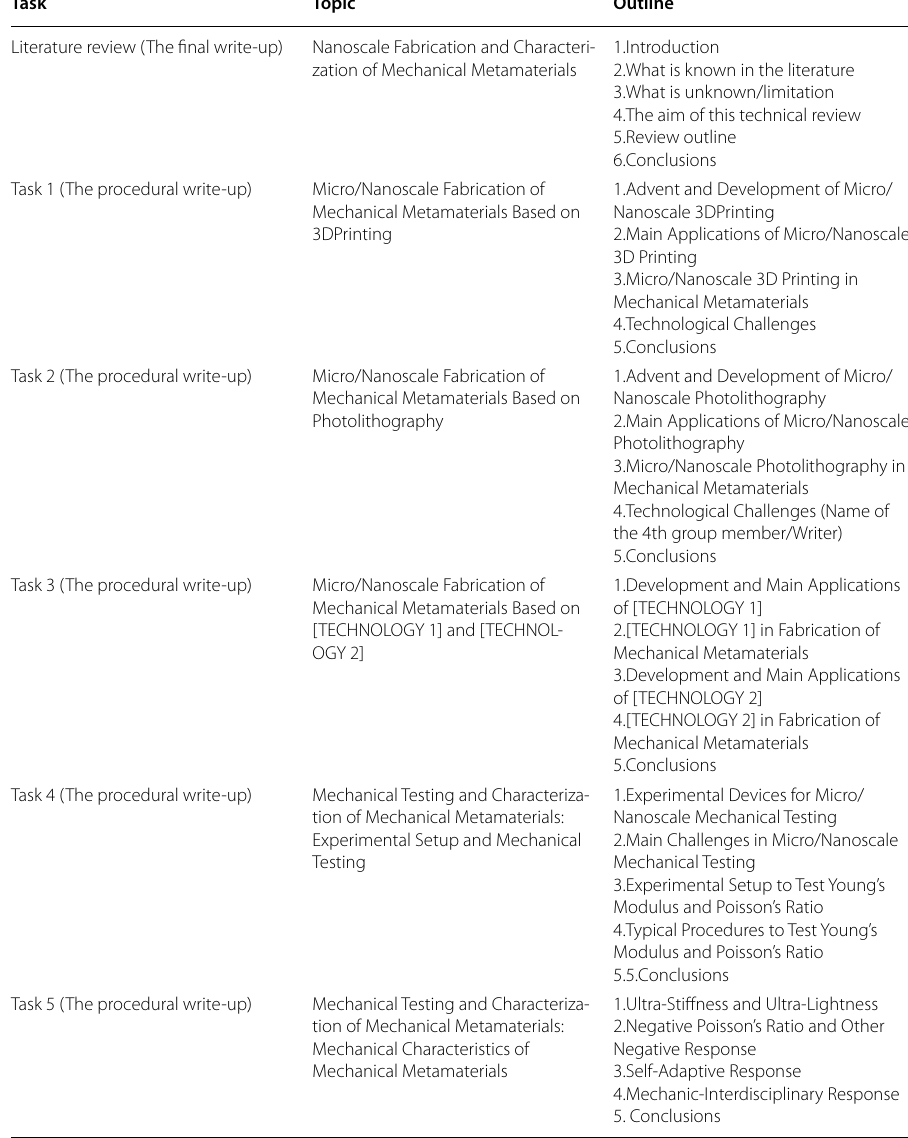
Table 8 The writing tasks and topics Task Topic Outline Literature review (The final